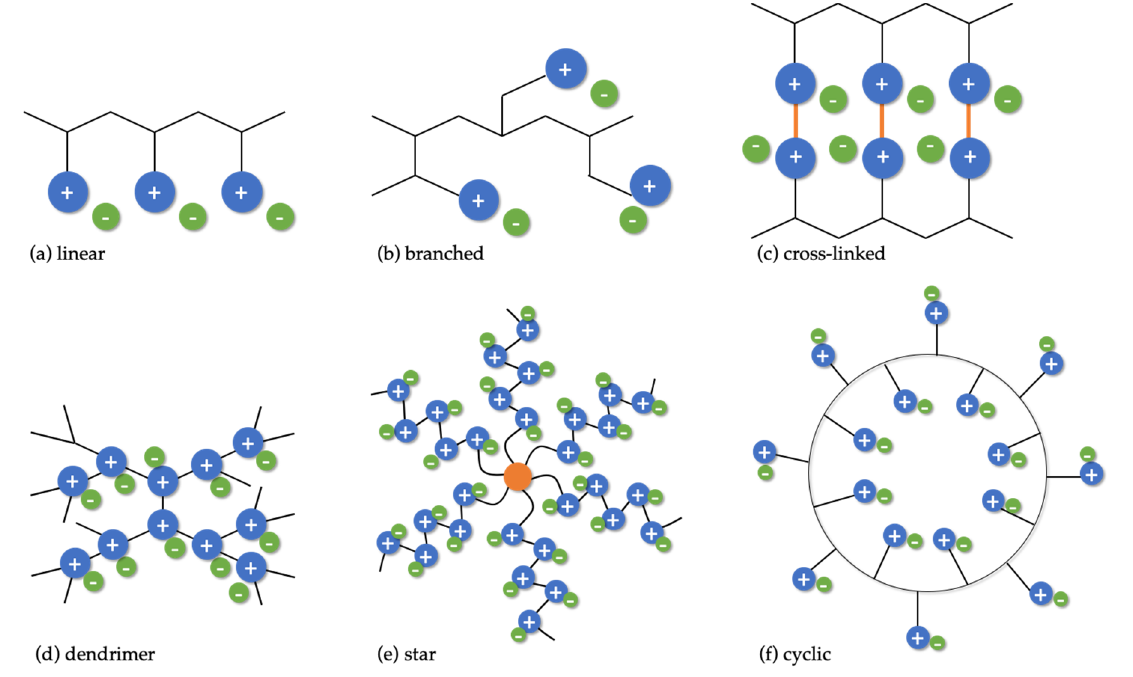
Figure 4. Schematic overview of the different architectures of polymeric ionic liquids (PILs), based on polycations. Blue spheres: cationic moieties; green spheres, anions. Analogous structures are possible with polyanions.